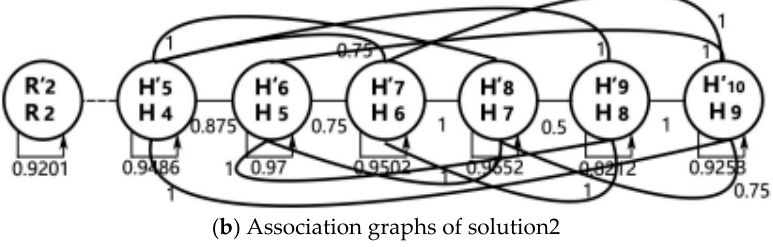
Figure 19. Association graphs of possible matching solutions between R 2 and R ’ 2 .